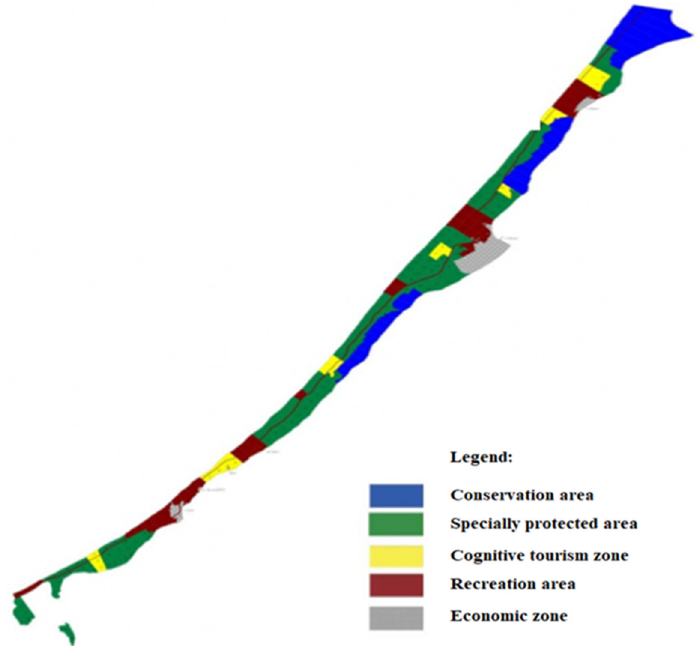
Figure 8. Functional zoning scheme of the Curonian Spit National Park [51].